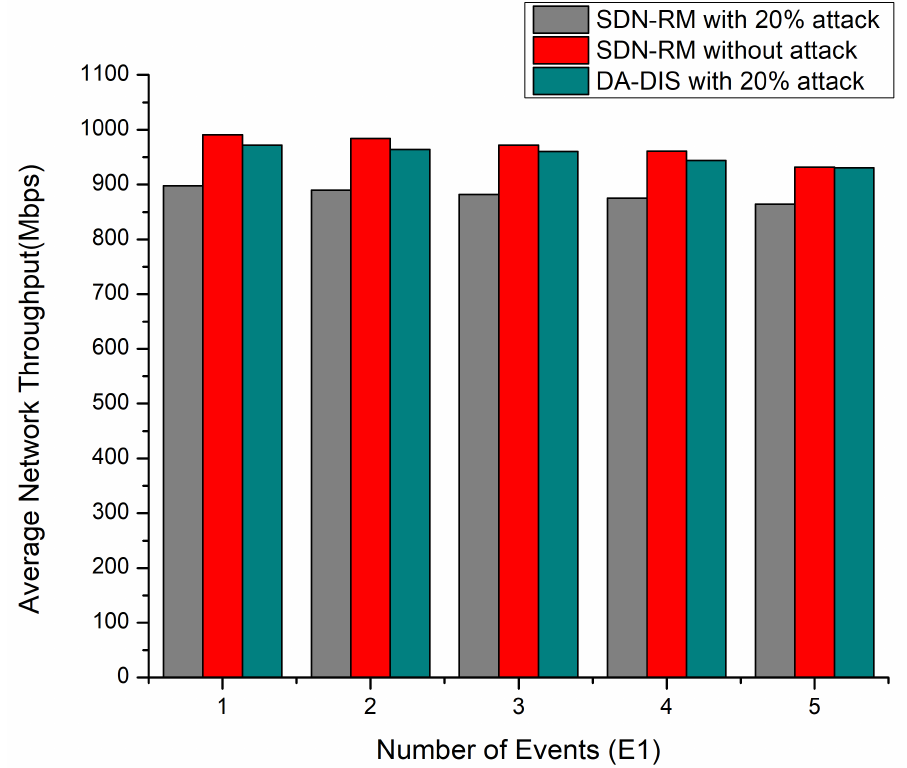
Figure 4. Throughput considering a different number of events (E1) and 20% malicious